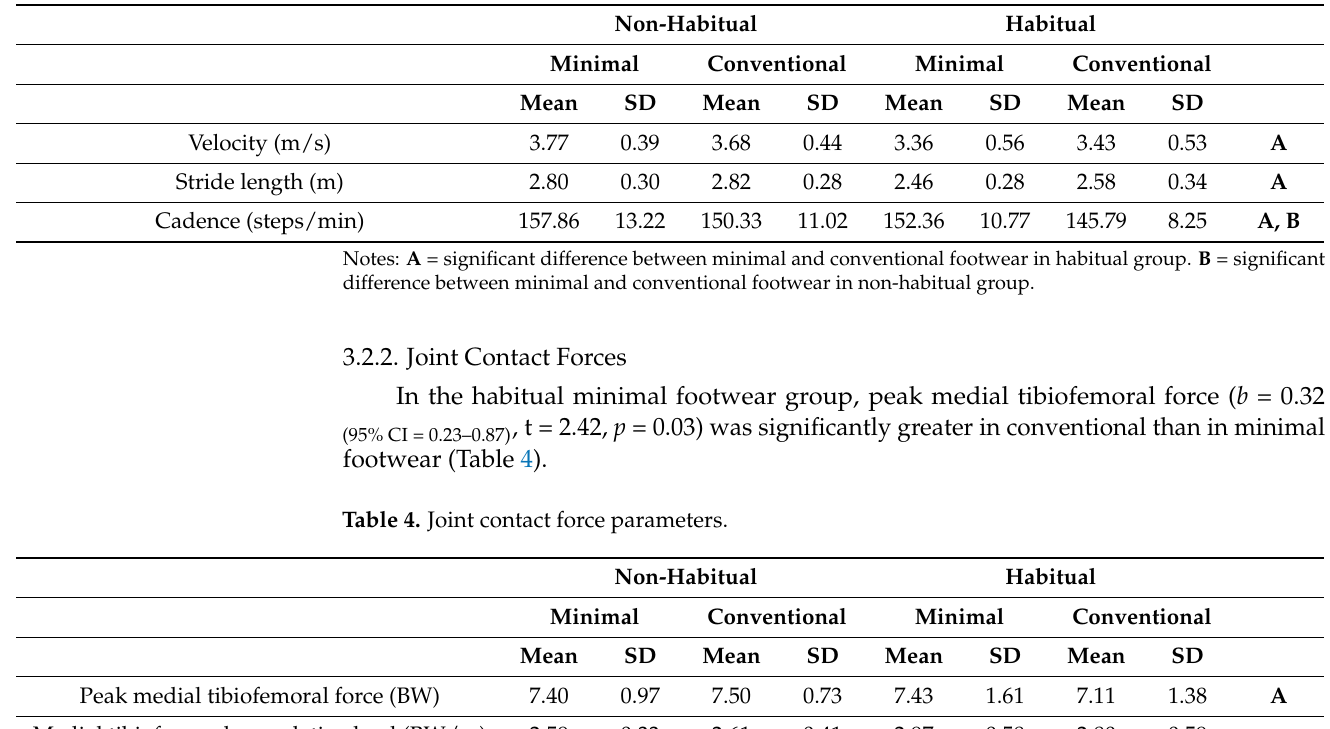
Table 3. Spatiotemporal variables.